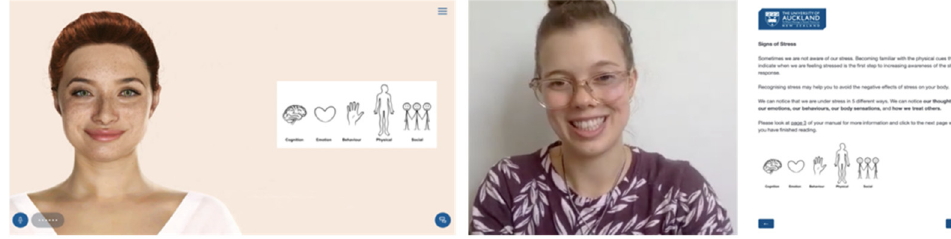
Figure 1. The CBSM delivery methods (left to right: a virtual human; a human teletherapist over video call; a self-guided e-manual).